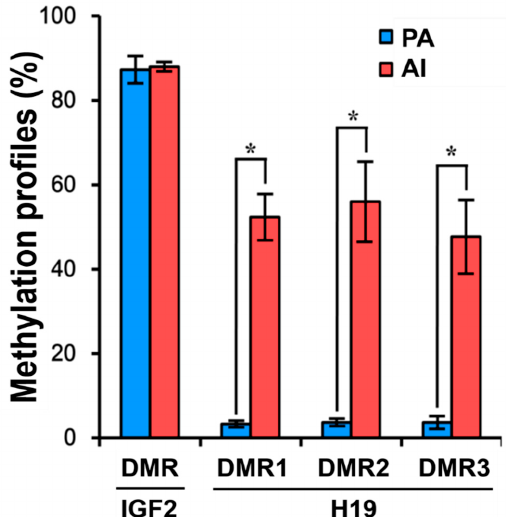
Figure 5. Analysis of apoptosis in PA and AI embryos and fetuses. An in situ cell death detection assay (TUNEL) was performed to measure apoptotic cells in PA and AI embryos and fetuses. The number of apoptotic cells was determined based on observation of a random field. * PA vs. AI ( p < 0.05).